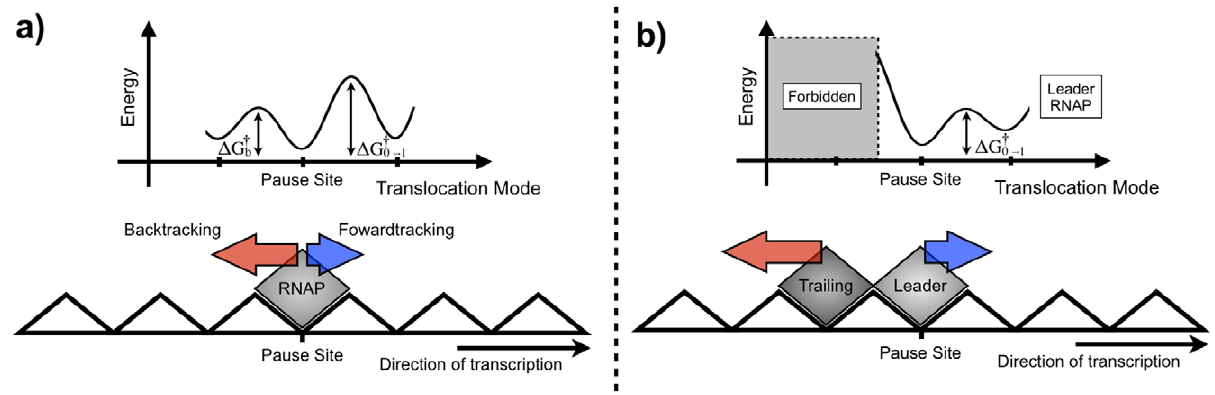
Figure 8. Schematic view of the roadblock effect: a) At a pause site the backtracking probability is higher than the probability of normal elongation. b) The trailing RNAP acts a roadblock preventing the backward movement of the leader RNAP.